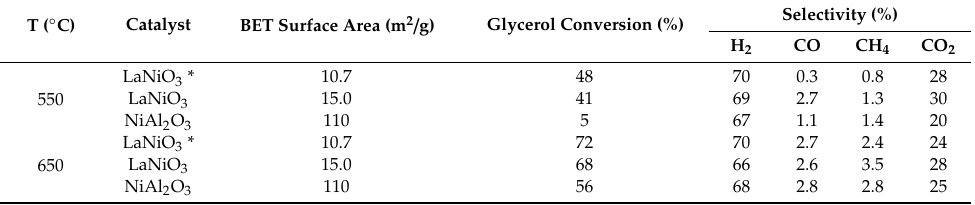
Table 10. Catalytic performance of di ff erent catalysts in SR of glycerol [95] (used with copyright